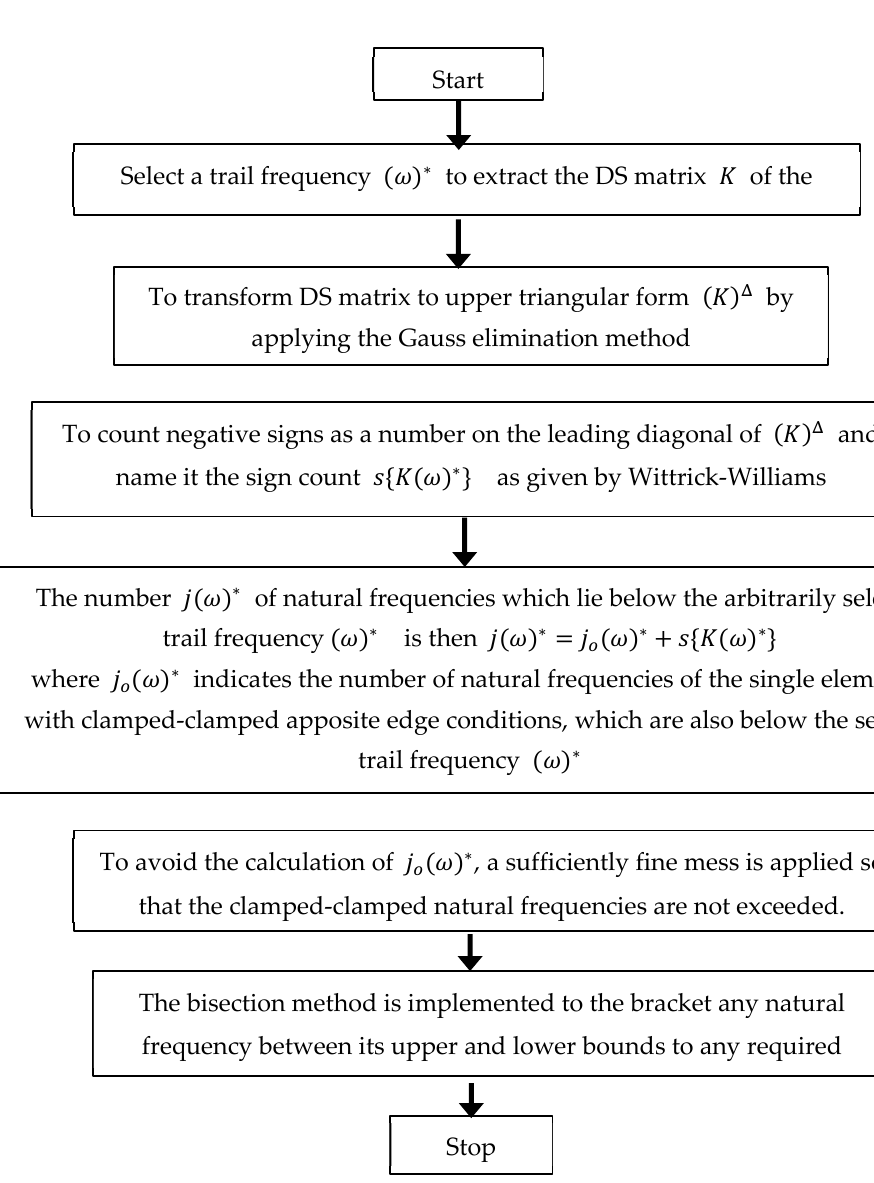
Figure 5. Flow chart for implementing the W–W algorithm.